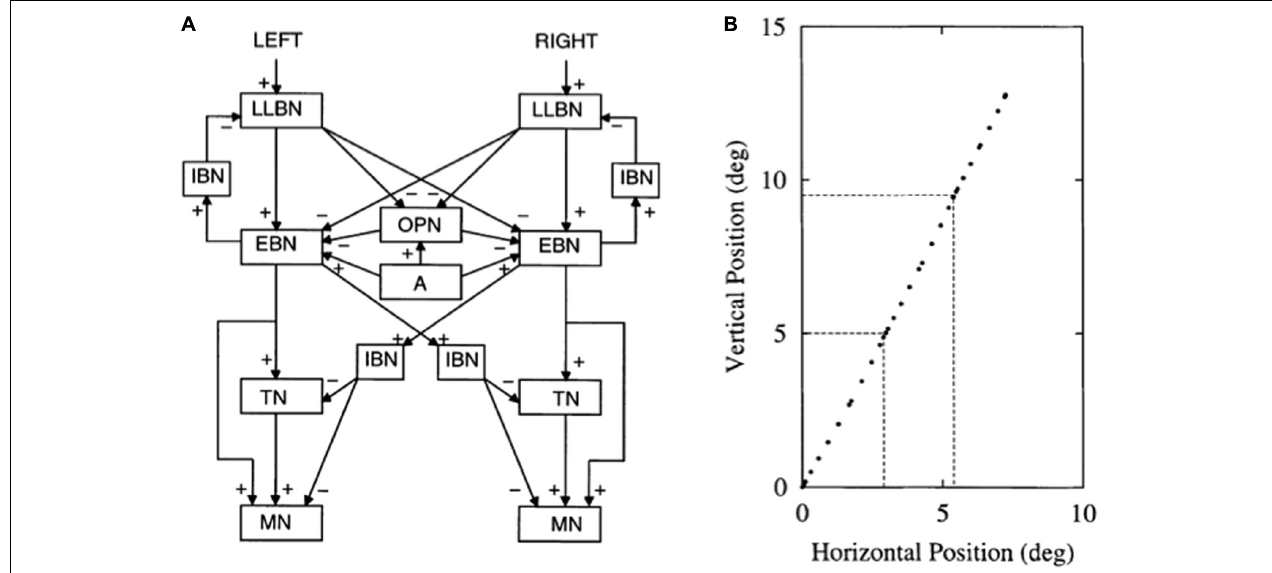
FIGURE 13 | The FOVEATE (Feedback Opponent VEctor ArchiTEcture) neural model of the saccade generator circuit in the peripontine reticular formation for control of an antagonistic pair of extraocular muscles. (A) Note the recurrent interactions between long-lead burst neurons (LLBN), excitatory burst neurons (EBN), and inhibitory burst neurons (IBN). These recurrent interactions support saccade staircases when movement gates (omnipause neurons) stay open long enough. Omnipause neurons = OPN; arousal signal = A; tonic neurons = TN; and motorneurons = MN. (B) Computer simulation of a sequence of three saccades, all in the same direction as the initial saccade, that is caused by a sustained constant input to the saccade generator. Eye position was sampled at regular time intervals. Reprinted from Gancarz and Grossberg